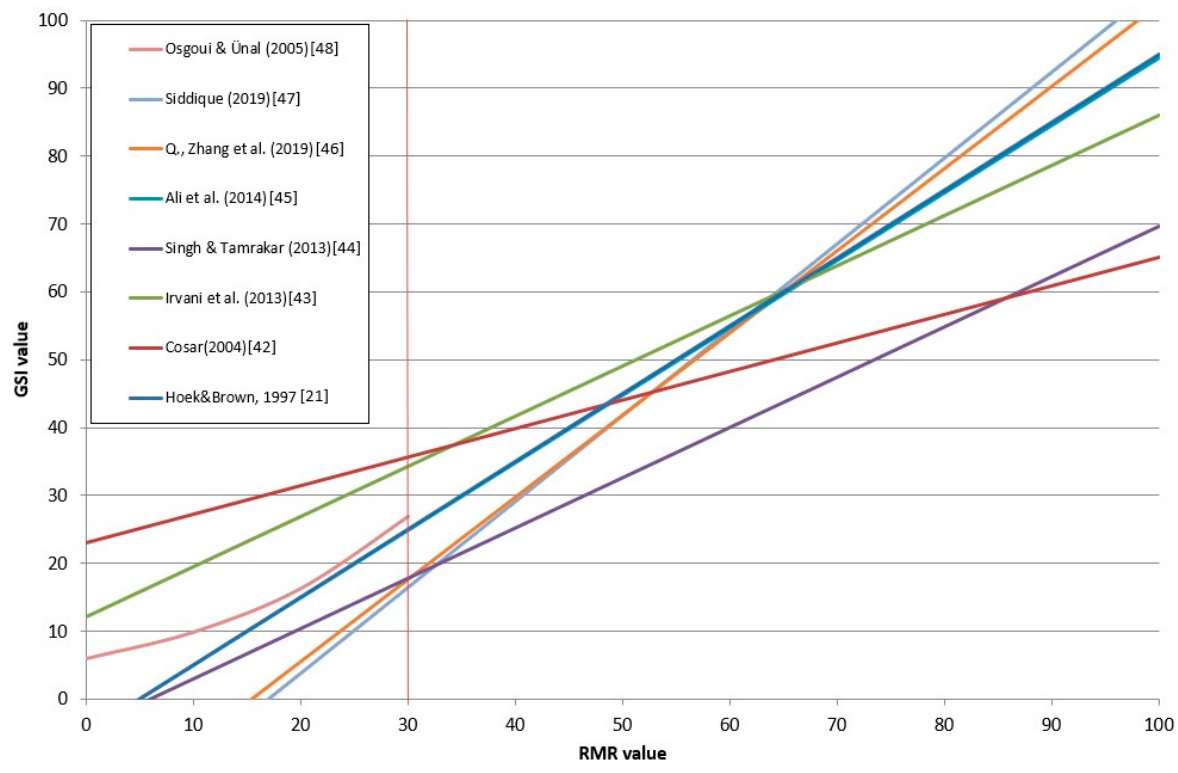
Figure 2. Existing correlations between RMR 89 and GSI listed in Table